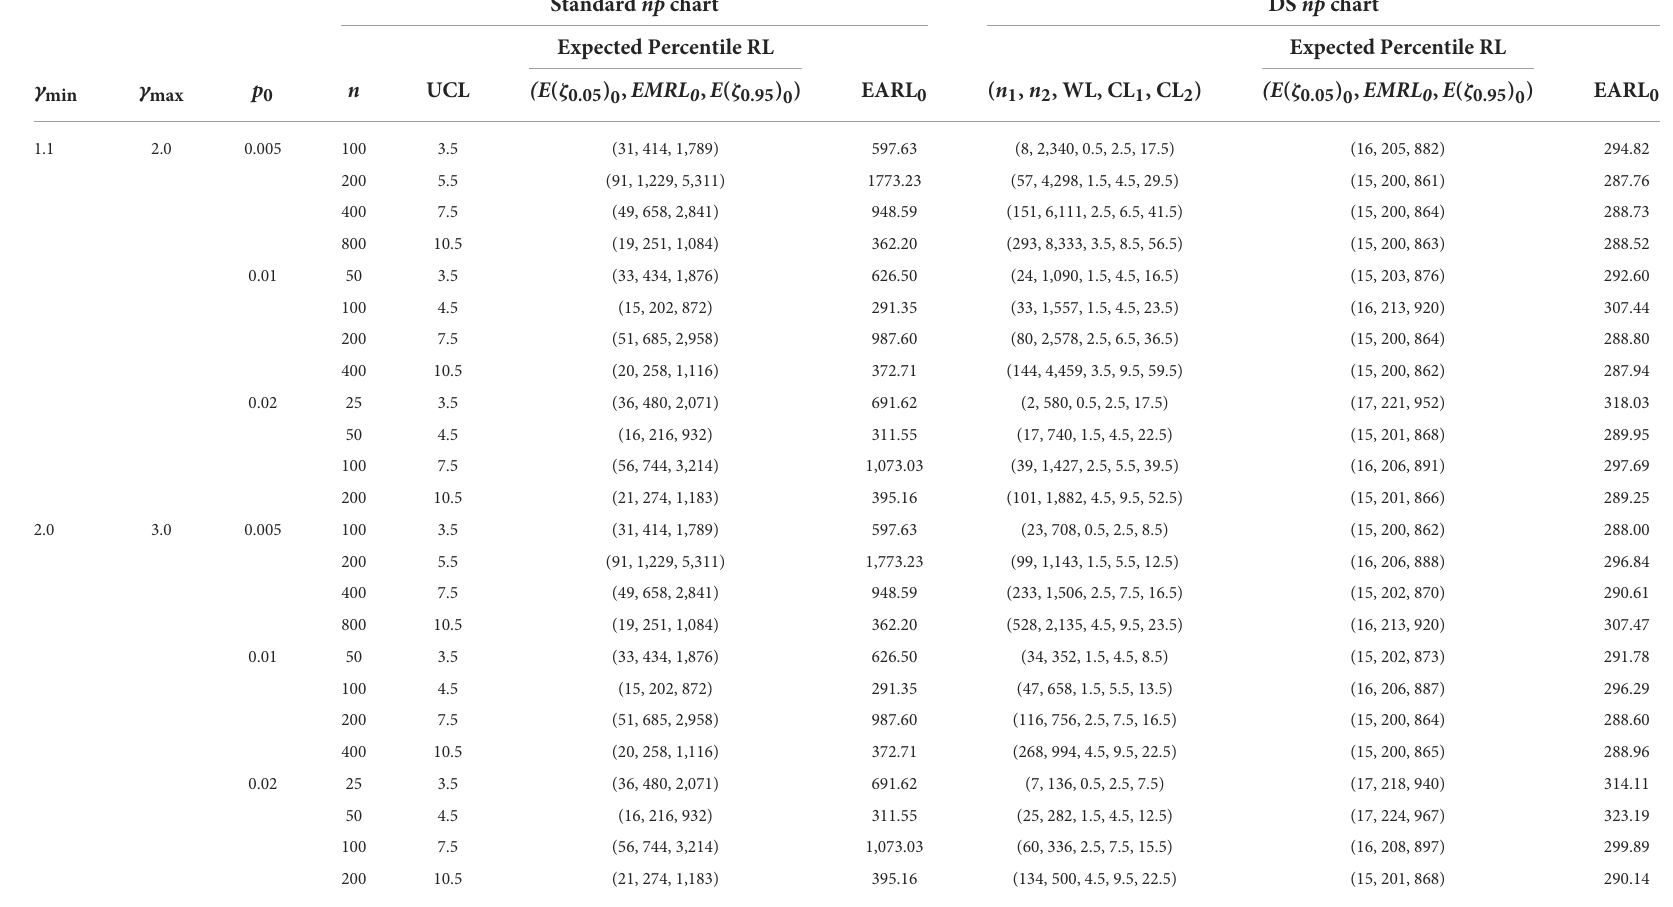
TABLE 1 Charting parameters with corresponding (E( ζ 0.05 ) 0 ,EMRL 0 ,E( ζ 0.95 ) 0 ) and EARL 0 for standard np and optimal DS np charts, when MRL 0min = 200. Standard np chart DS np